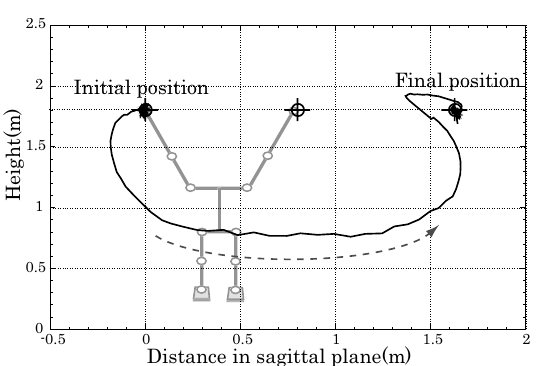
Figure 19 Trajectory of free hand during side-hand brachiation. Figure 18 Transitions of evaluation values (side-hand brachiation).